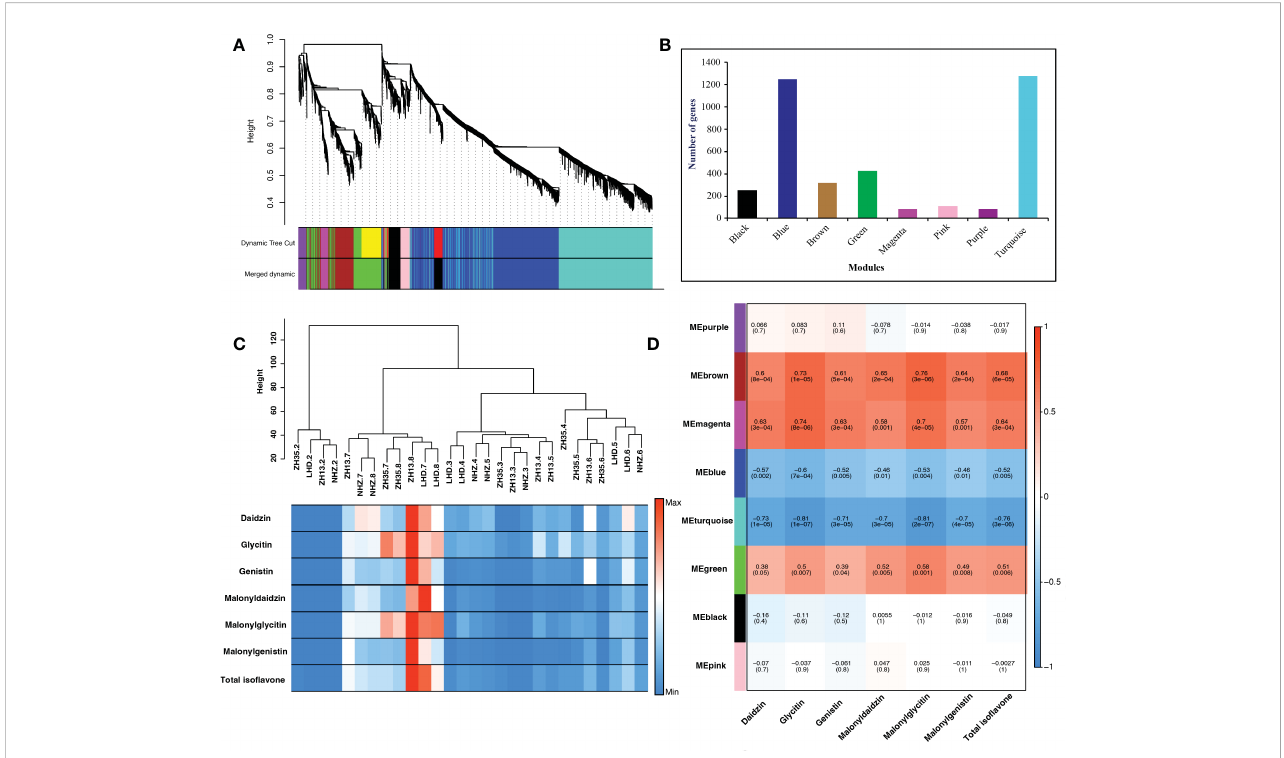
FIGURE 4 (A) Module clustering, different colors represent different modules. (B) Number of genes in each module. (C) Sample dendrogram and trait heatmap, each row corresponds to the iso fl avone content, while each column corresponds to seed samples of four soybean cultivars (LHD, NHZ, ZH13, and ZH35) collected at different seed developmental stages (R5-R8). The right panel represents the minimum (blue color) and maximum (red color) iso fl avones accumulation at different seed developmental stages. (D) Module trait relationship, each row corresponds to a module, while each column corresponds to the iso fl avone content. The left panel shows the modules, while the right panel shows positive (red, 1) and negative (blue, − 1) correlations.